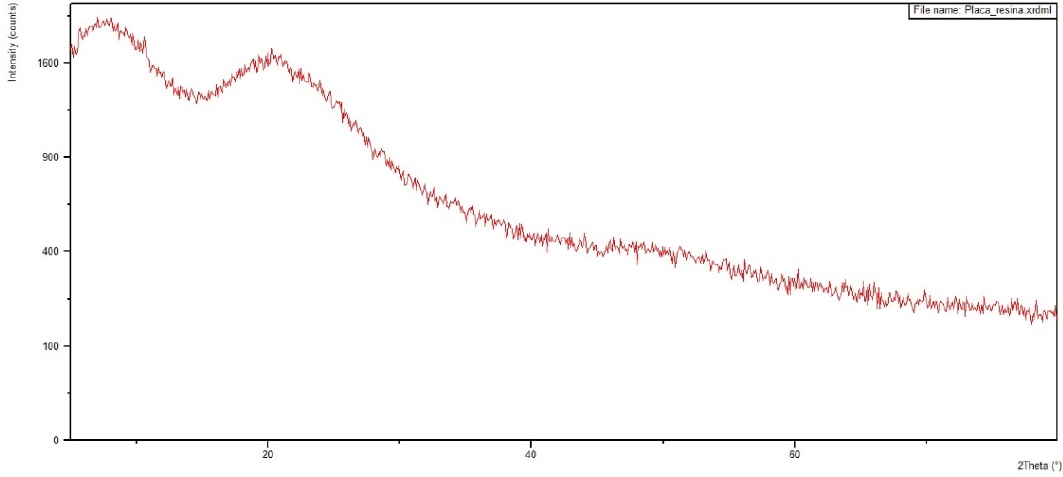
Figure 14. Diffractogram of plain epoxy resin.